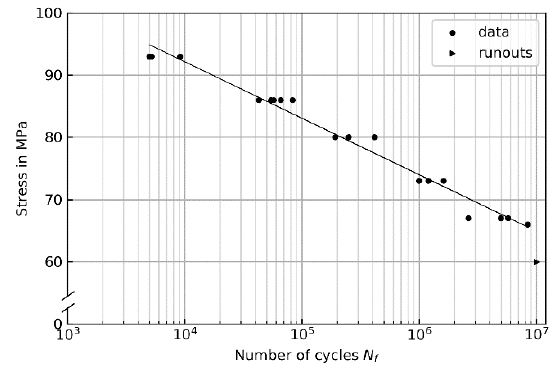
Figure 9. S-N-data. Figure 9.